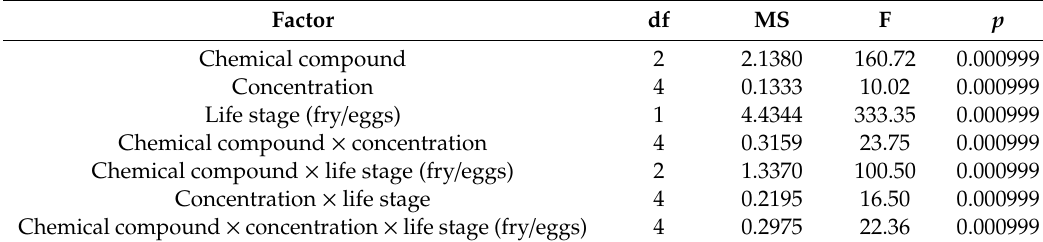
Table 3. PERMANOVA analysis of the factors (chemical compound, concentration, life stage, and their combinations) affecting the Ag concentration in the fry and eggs of rainbow